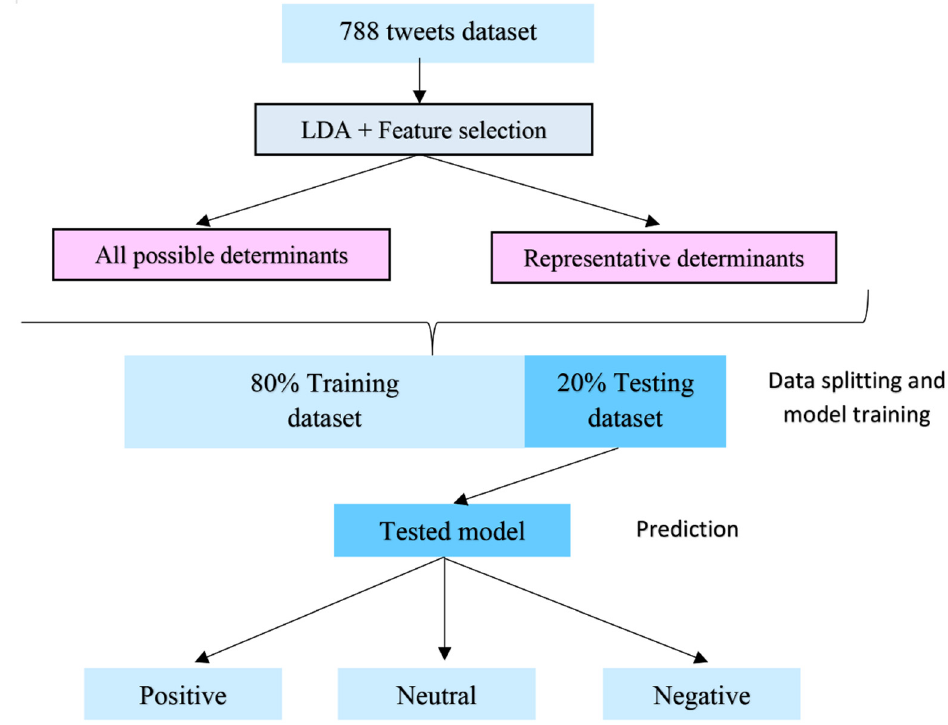
Figure 3. The process of multinomial regression model build-up with two different groups of features as input data .